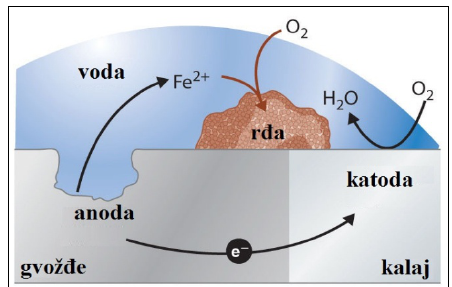
Рис . 13 – Механизм гальванической коррозии Figure 13 – The mechanism of galvanic corrosion